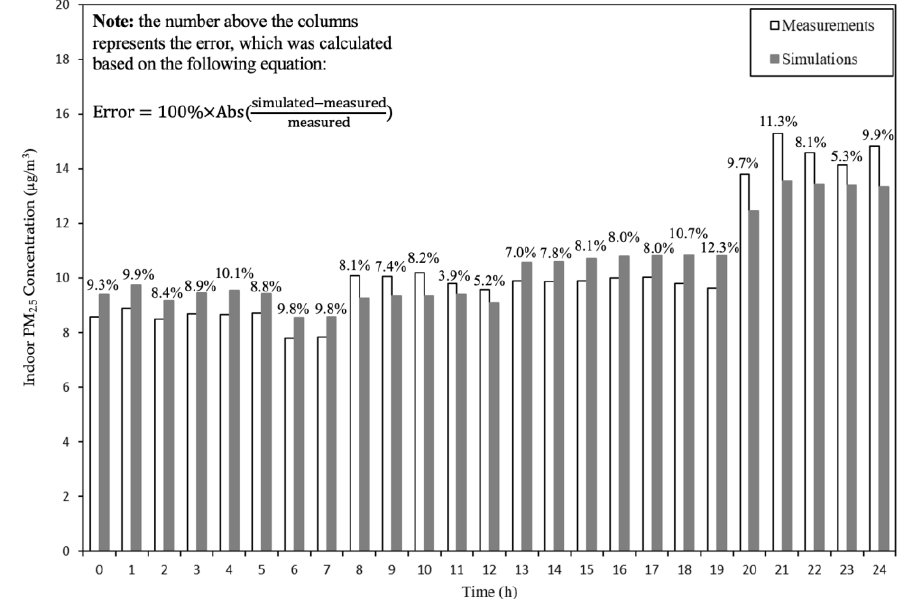
Figure 4. The measured and simulated indoor PM 2.5 concentrations for the flat.